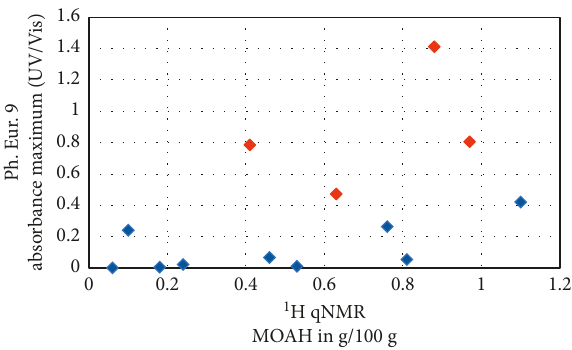
Figure 10: Comparison of the methods Ph. Eur. 9 and 1 H qNMR for 13 vaseline samples (blue: pharmaceutical quality; red: technical quality).